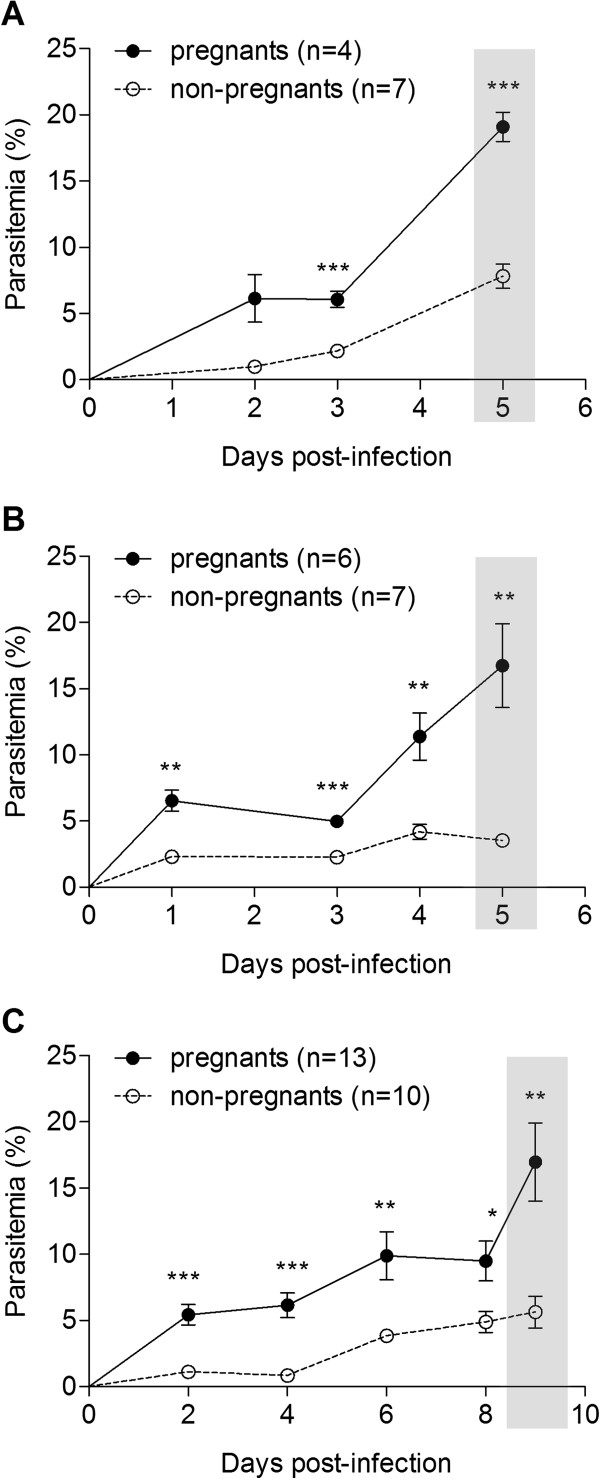
Maternal susceptibility to infection. (A) Time-course parasitaemia of P. berghei K173 (A), NK65 (B) and ANKAΔpm4 (C) in C57BL/6 pregnant and non-pregnant females. Animals were infected i.v. with 106 IE at G13 (A, B) or at G10 (C). Highlighted area corresponds to G18 (A, B) or G19 (C). Parasitaemia of DRAQ-5 labelled samples was followed by FACS. Unpaired t test (WelchÂ´s correction) *p<0.05; ** p<0.01; ***p<0.001.